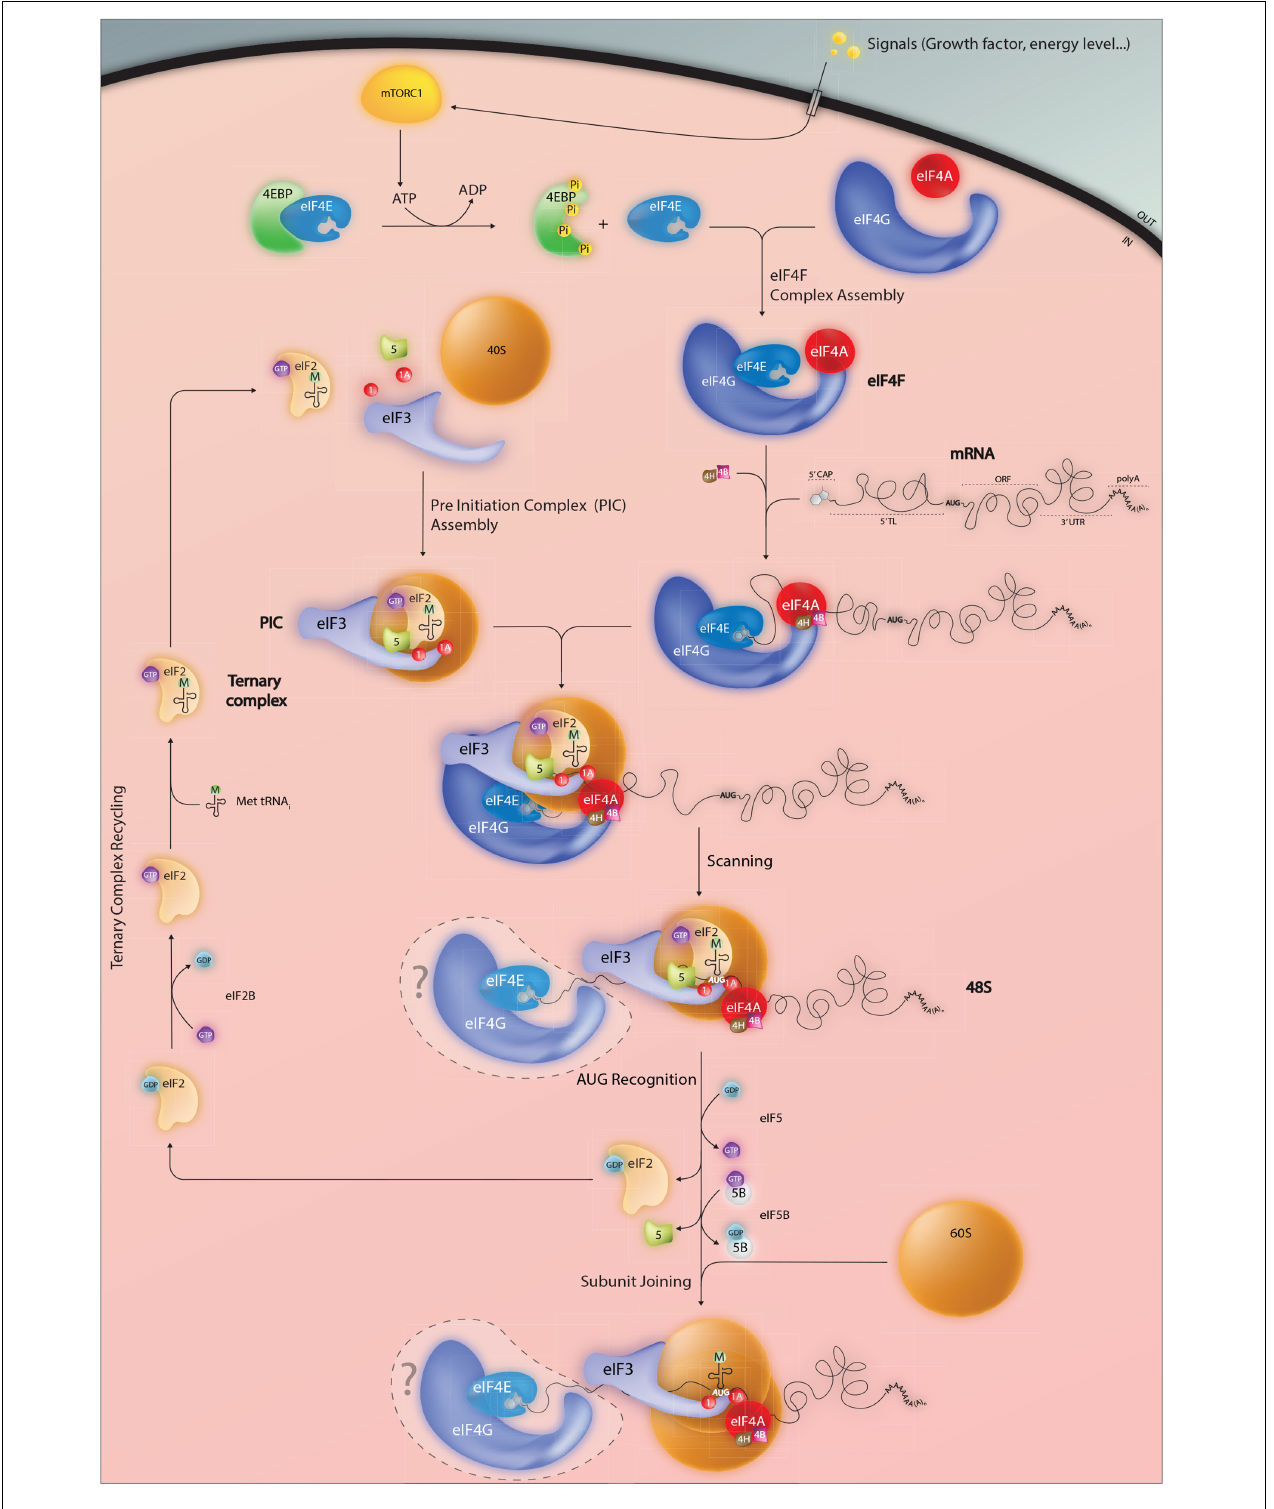
FIGURE 1 | Events impacting on the assembly of the initiation complex on the AUG start codon. Mature mammalian mRNAs are exported from the nucleus into the cytoplasm carrying a distinctive 5 (cid:48) cap structure. This is recognized by the eukaryotic initiation factor eIF4E which forms part of the trimolecular eIF4F complex. RNA structure close to the 5 (cid:48) can limit cap accessibility and consequently plays an important role in modulating protein expression levels. In addition, active